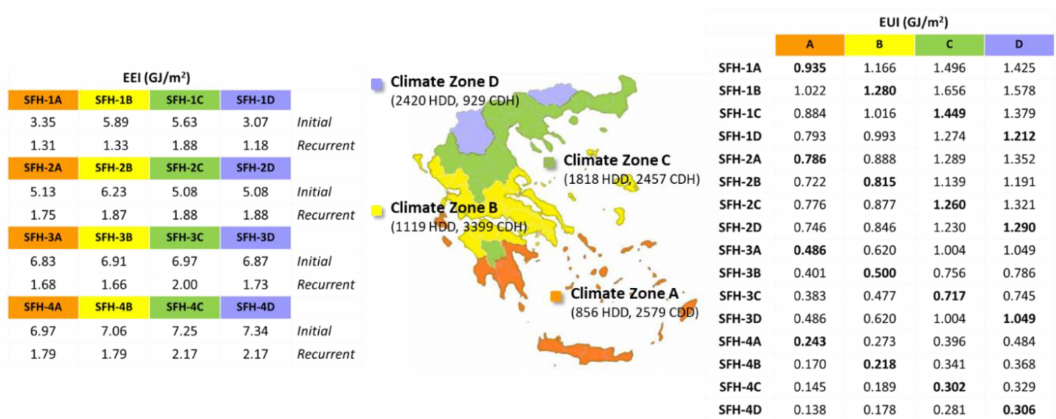
Figure 5. Primary initial EE and recurrent EE (for an 80-year building lifetime) embodied energy intensities (EEIs) and annual energy use intensities (EUIs) expressed in GJ / m 2 for all the 16 case study buildings (Table 1) in the four climate zones of Greece, including the average heating degree days (HDD) and cooling degree days (CDD) in each